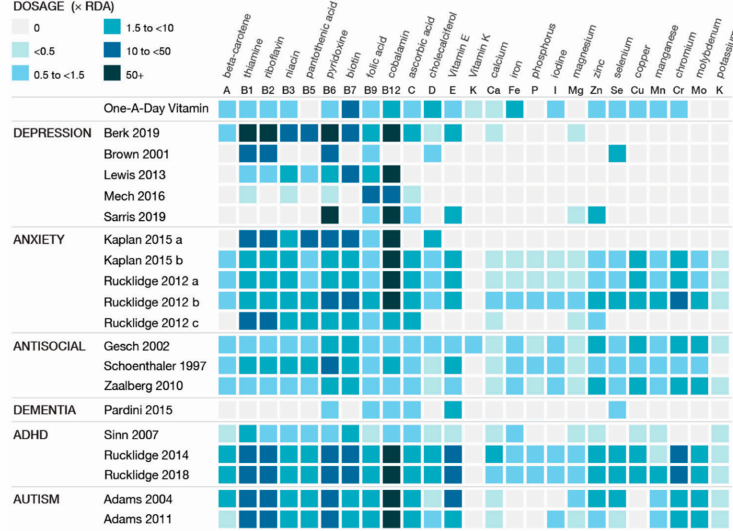
Figure 3. Comparing formula ingredient dosages of vitamins and minerals based on the Recommended Dietary Allowance (RDA). Kaplan, 2015 a = complex B vitamin; Kaplan, 2015 b = EMP + , 4 capsules; Rucklidge, 2012 a = EMP + , 4 capsules; Rucklidge, 2012 b = EMP + , 8 capsules; Rucklidge, 2012 c = complex B vitamins with